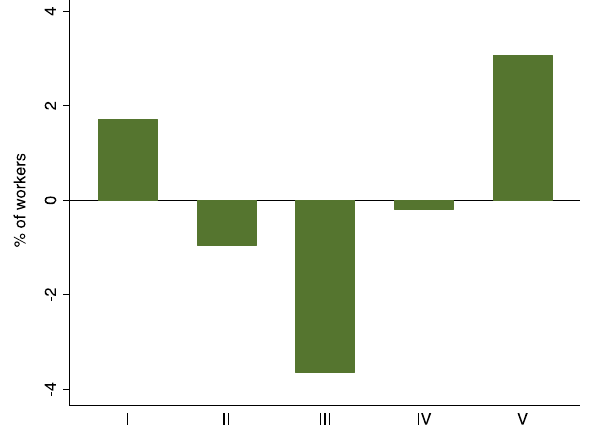
Fig. 3 Relativenetemploymentchange(1994,2014)rankedby2002wagemean. Notes jobswagequintiles are based on two-digit occupation and one-digit industry and on mean wages in 2002. It shows the relative netemploymentchangequintiles(inpercentagepoints). Sources :author’sanalysisfromtheSpanishLabour Force Survey (1994, 2014), Earnings Structure Survey